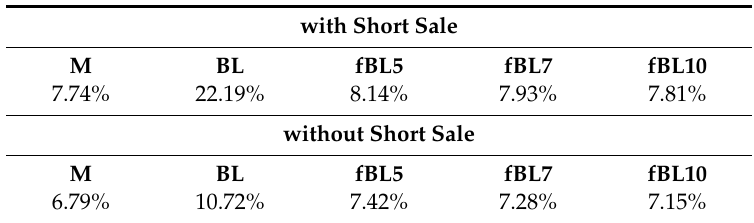
Table 4. Standard deviation of monthly returns.